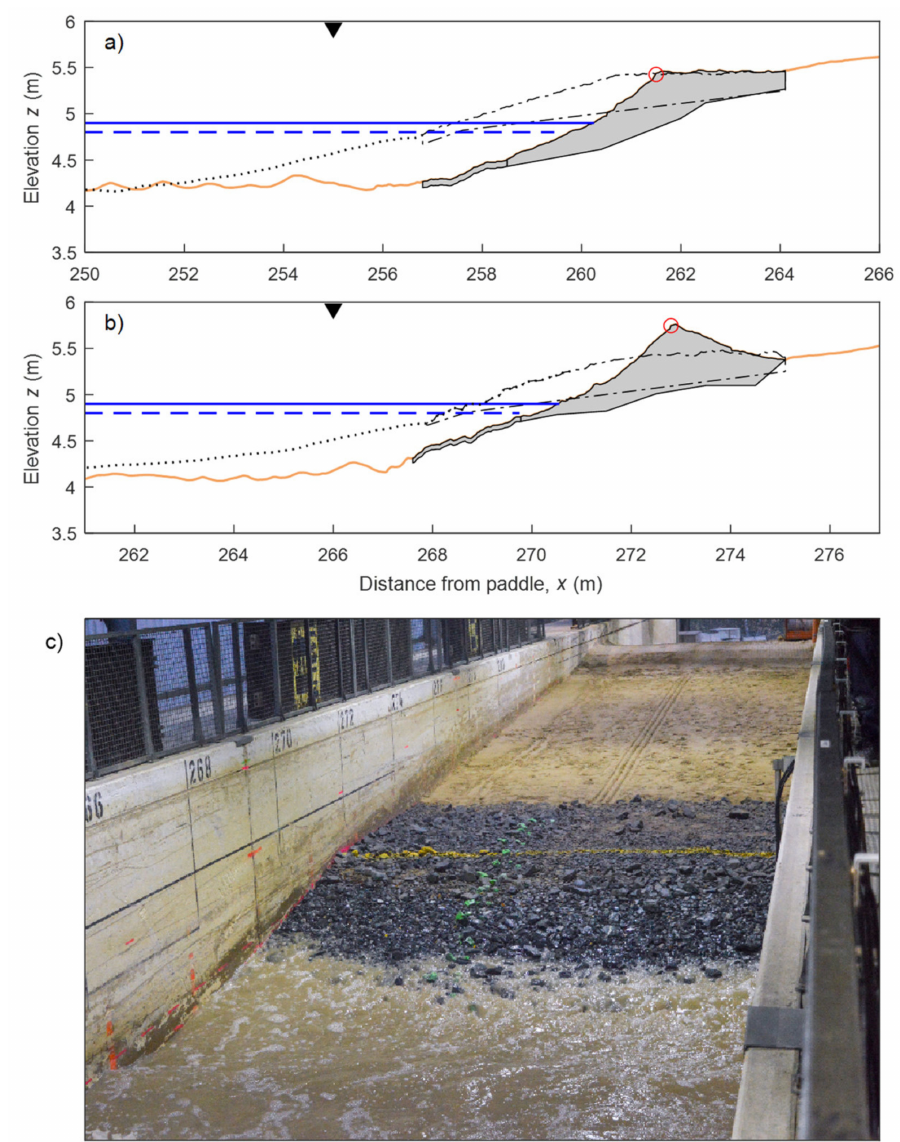
Figure 1. Sandy beach and revetment geometry for ( a ) DynaRev1 and ( b ) DynaRev2. The filled grey region and orange line indicate the dynamic revetment and sand beach profile at the end of testing at z WL = 4.9 m. The dot-dashed region shows the initial revetment cross-section, and the dotted black line indicates the sand profile after revetment construction. The dashed blue horizontal line indicates z WL = 4.8 m, and the solid blue dashed line shows z WL = 4.9 m. The crest locations for the final profiles are marked by a red circle. The black triangles mark the cross-shore position of the Lidar, the Lidar elevation is z = 11.8 m and the swath is approximately 30 m in length in both experiments and so covers the entire region shown in panels a and b. ( c ) Photograph of the DynaRev2